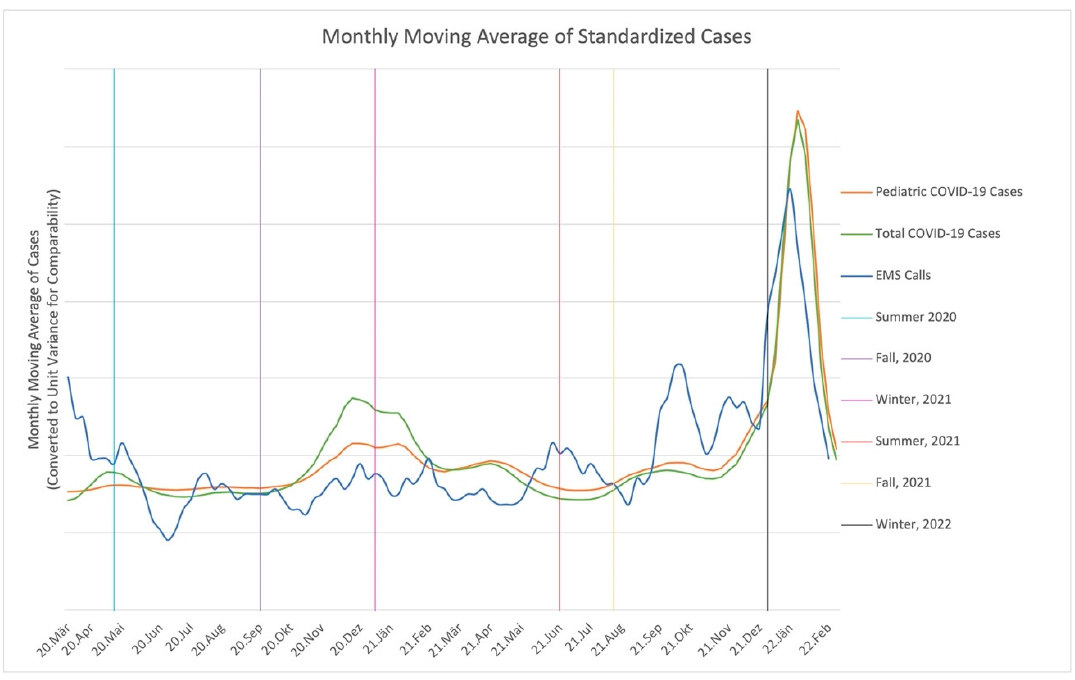
Figure 1. Statewide chronological trends of weekly ambulance calls due to suspected infectious diseases and positive COVID-19 test results.